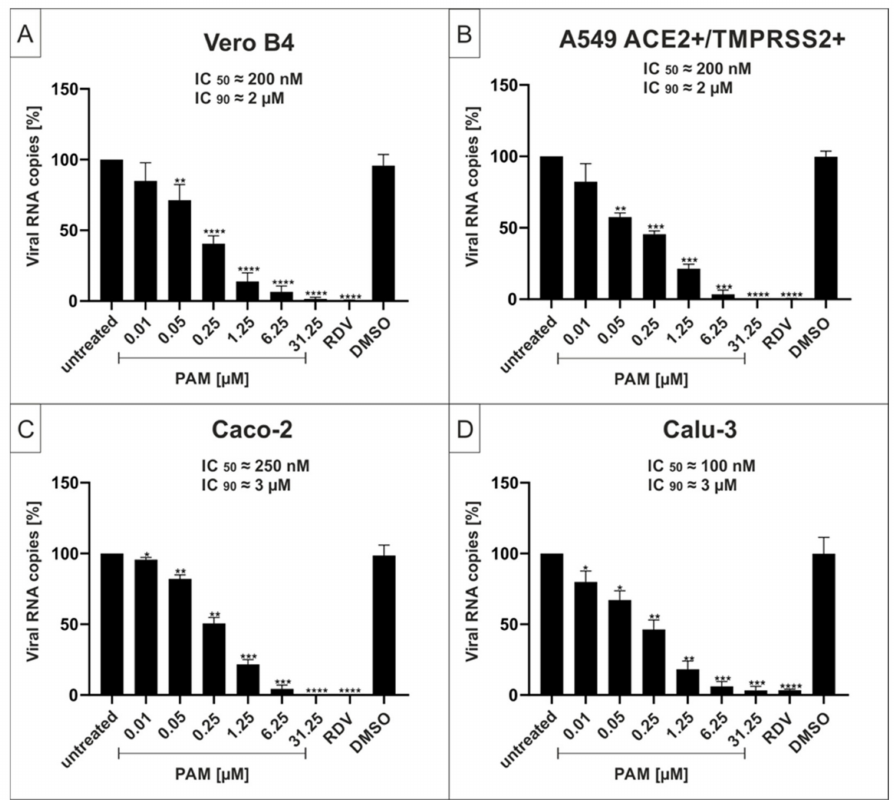
Figure 1. Pamapimod (PAM) inhibits replication of SARS-CoV-2 Wuhan type with comparable antiviral efficacy in various cell lines. Vero B4 ( A ), A549-ACE2+/TMPRSS2+ ( B ), Caco-2 ( C ), and Calu-3 cells ( D ) were infected with the clinical isolate SARS-CoV-2 PR-1 at a MOI of 2 × 10 − 2 . One hour after infection and removal of input virus, cells were treated with the indicated concentrations of PAM; 1 µ M Remdesivir (RDV) was included as a positive control, and DMSO was added as a solvent control in the same amount as to the highest used amount of PAM (31.25 µ M). Cell culture supernatants were harvested at 3 dpi. The virions were purified and analyzed by qRT-PCR. Data represent means of three independent experiments ± standard deviation (* p < 0.046, ** p < 0.0086, *** p < 0.0006, and **** p < 0.0001) using a One sample t test, where each value is compared to the untreated